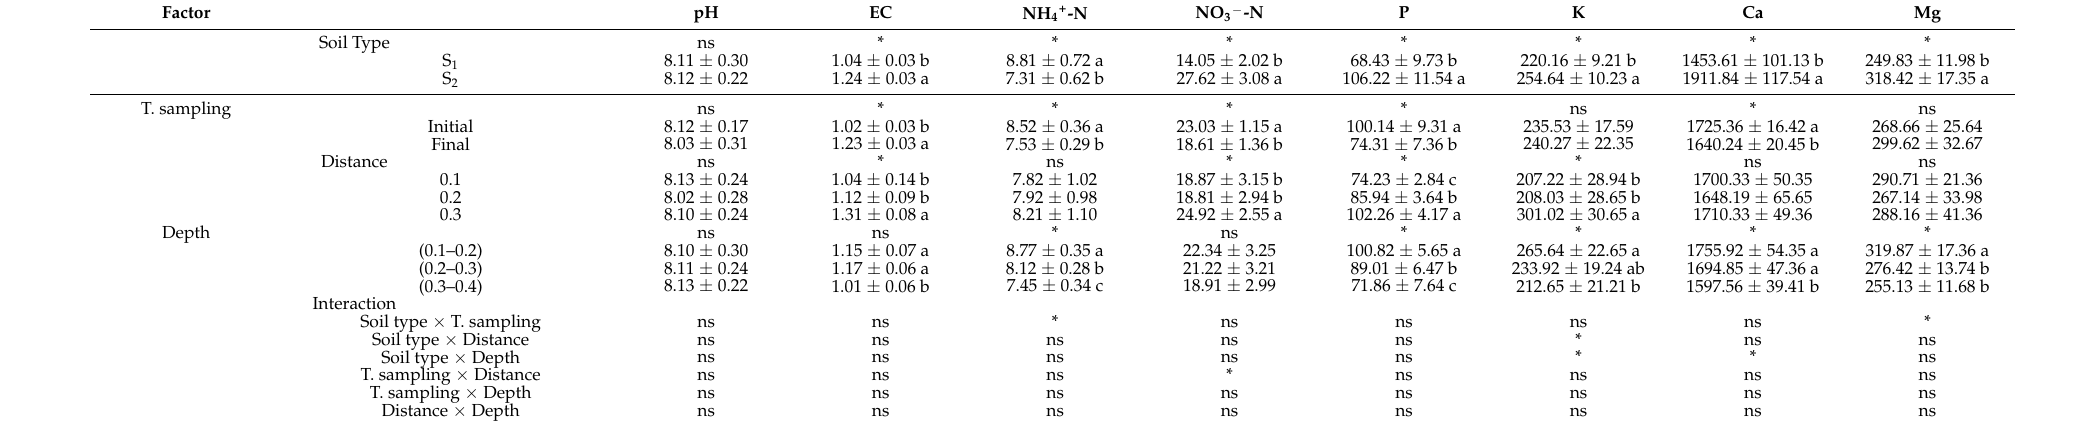
Table 3. Chemical parameters of soil profile depending on the studied factors: (A) soil type, (B) T. sampling (time of sampling), (C) distance from the emitter, (D) depth and their interactions. EC and nutrients concentration are expressed in dS m − 1 and mg kg − 1 ,